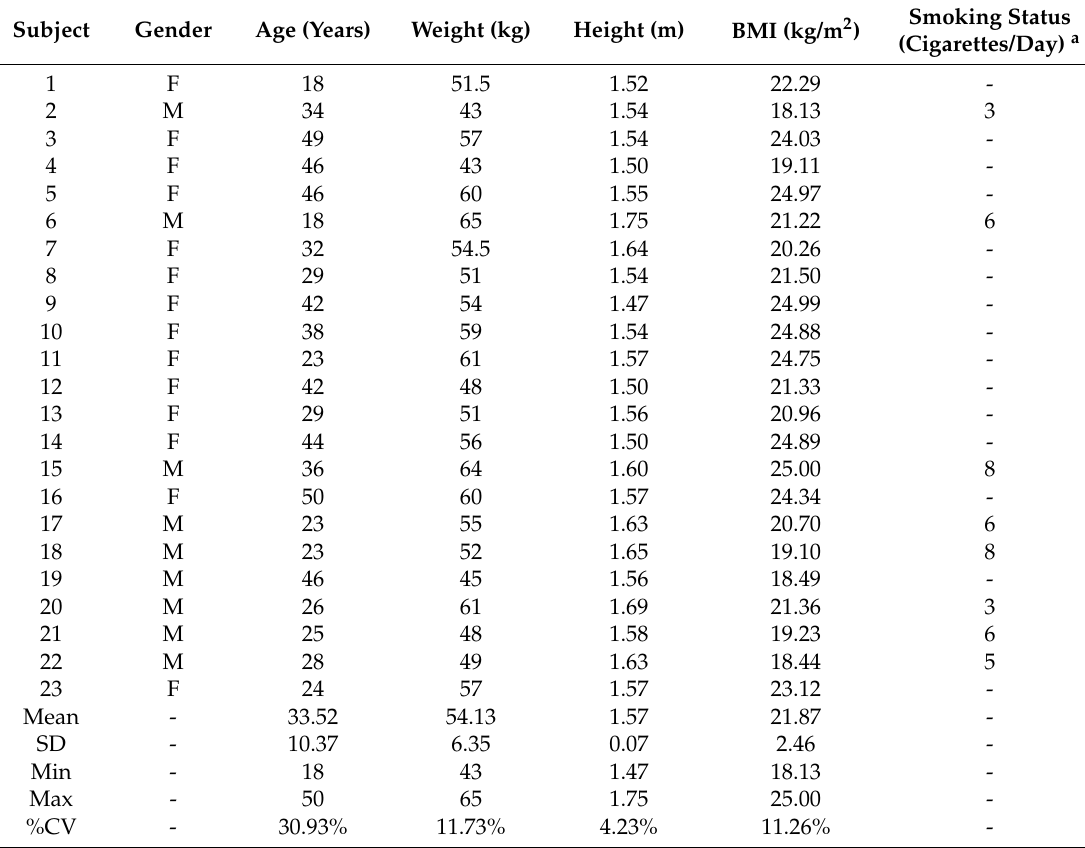
Table 2. Baseline characteristics of the study